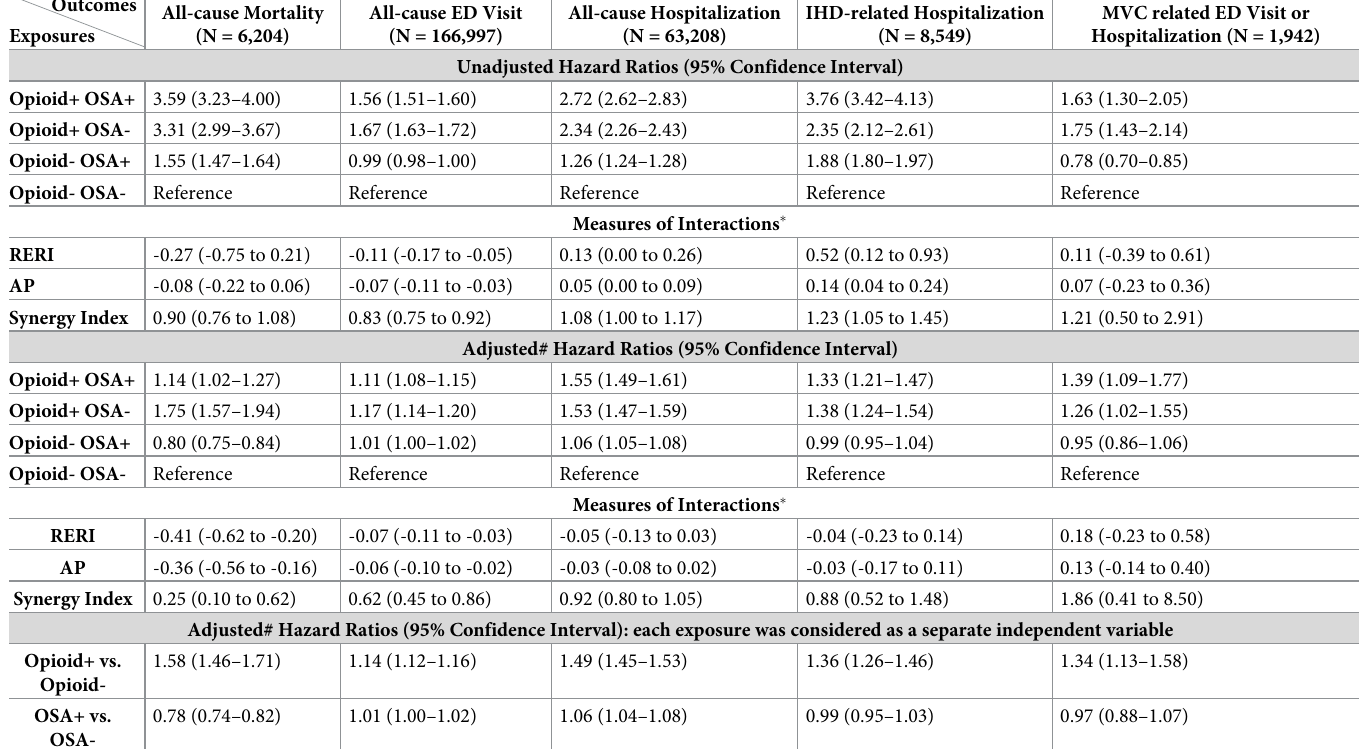
Table 2. Hazard ratios of all-cause mortality, all-cause emergency department (ED) visits, ischemic heart disease (IHD)-related hospitalizations, motor vehicle col- lision (MVC) related ED visits and/or hospitalizations and RERI, AP, synergy index, multiplicative measure of Interaction by four levels of